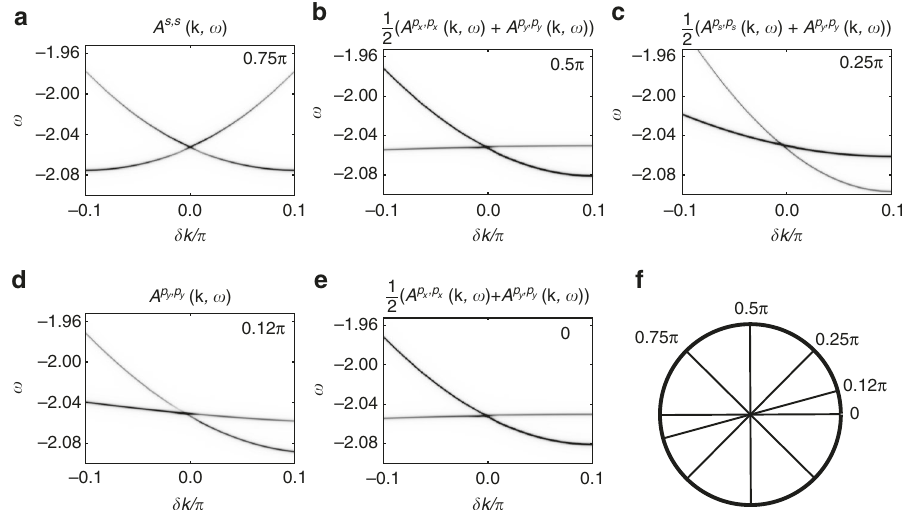
Fig. 2 Spectral weight cuts through the Dirac point. a – e Spectral weight A γ , γ ( k , ω ) for different cuts through the Dirac point. The projections γ were chosen so that both polaron bands are visible. f The orientation of the different cuts, parametrized as ( k x , k y ) = k C + δ k (cos ϕ , sin ϕ ). Parameters are t sp = − 1, t pp = − 0.49, ϵ = ϵ = 0, Ω = 1, α = 0.4 and β = s p